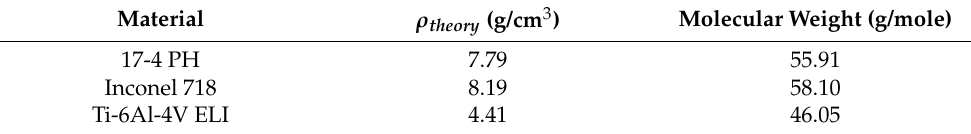
Table 3. Theoretical density and molecular weight of 17-4 PH, Inconel 718 and Ti-6Al-4V ELI.